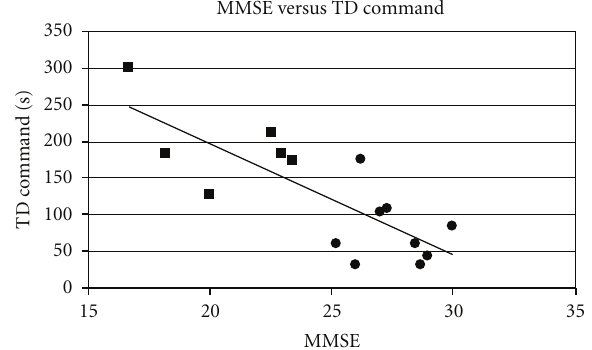
Figure 3: Relation between the MMSE scoring and duration in the CDT command condition ( r = − 0 . 75). Squares are PDD, circles are PD.